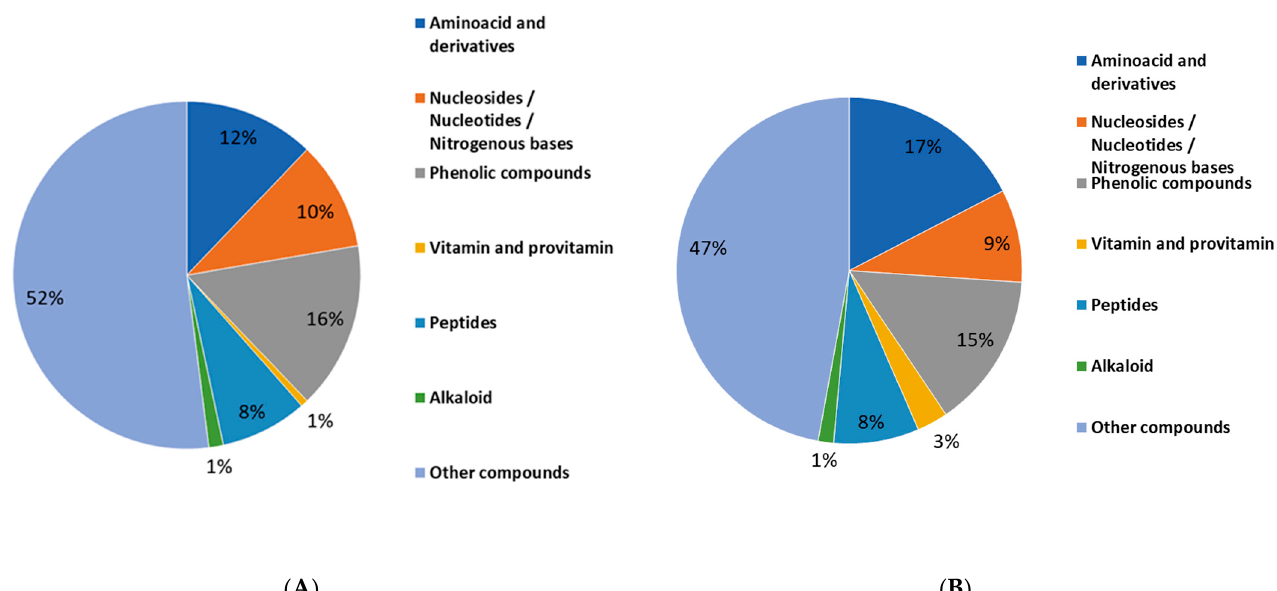
Figure 2. Percentage composition of the most relevant class of compounds which were identified in hulls of Eston green (panel A ) and Crimson red (panel B ) lentils according to the results that were retrieved using Compound Discoverer software.